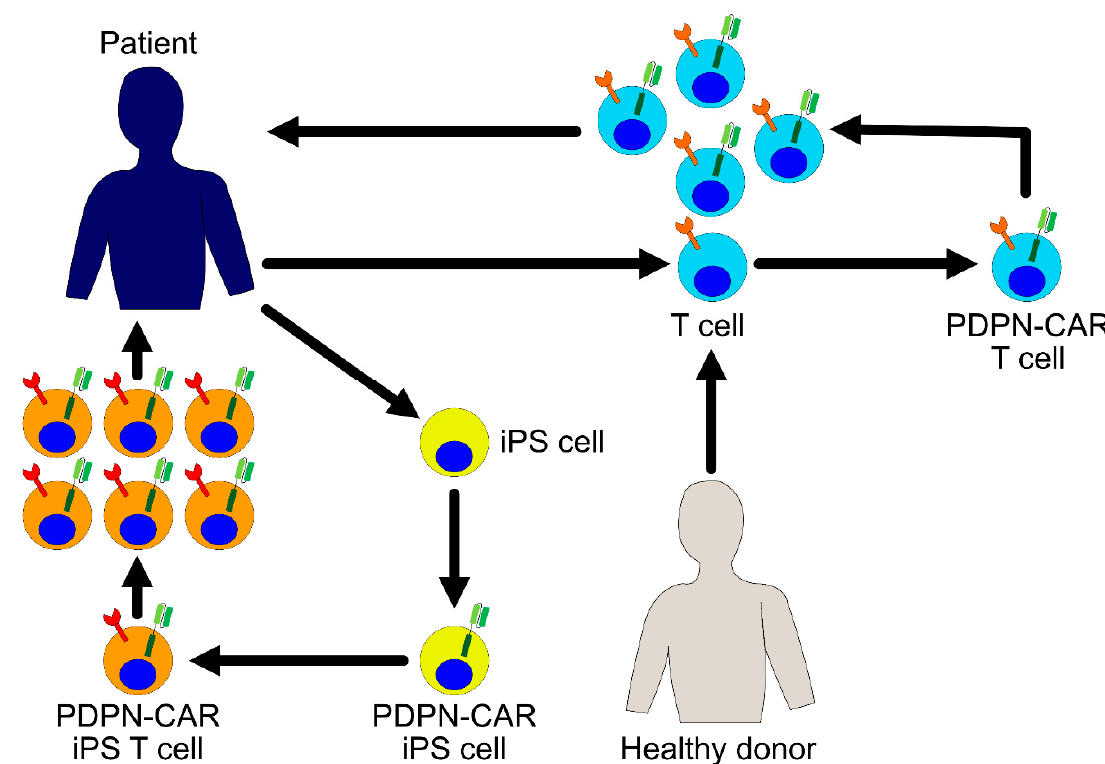
Figure 2. PDPN-CAR expressing T cells for cancer immunotherapy. Patient derived- or healthy donor derived-T cells are harvested and transduced with a PDPN-CAR encoding gene ex vivo. The PDPN-CAR T cells are further expanded ex vivo and infused into the patient. Another possible approach is to use induced pluripotent stem (iPS) cells as a source of T cells. iPS cells are established from patient’s somatic cells and transduced with a PDPN-CAR ex vivo. PDPN-CAR expressing T cells are differentiated from these iPS cells, expanded, and infused into the patient.